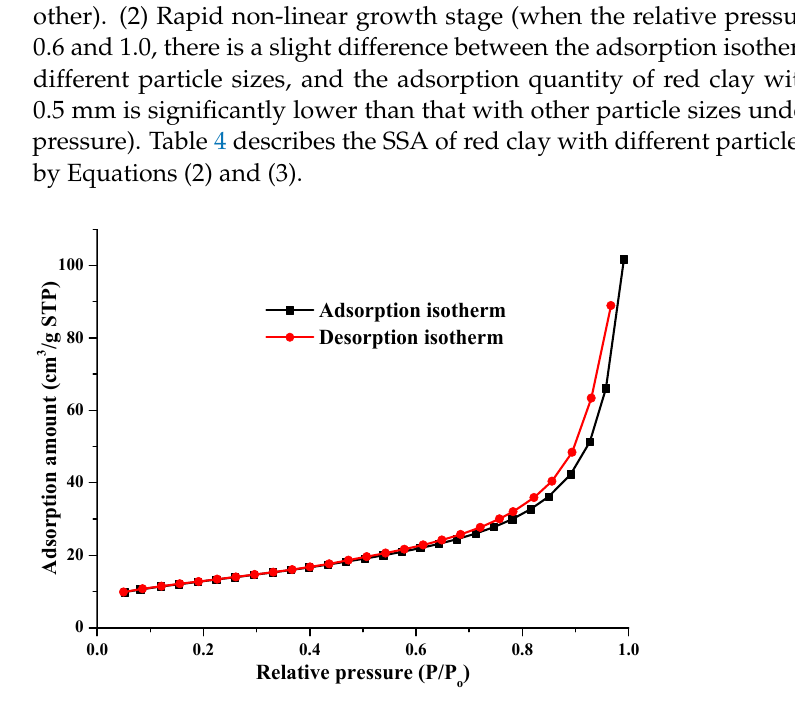
Figure 3. Adsorption–desorption isotherm of red clay (0.25 mm).